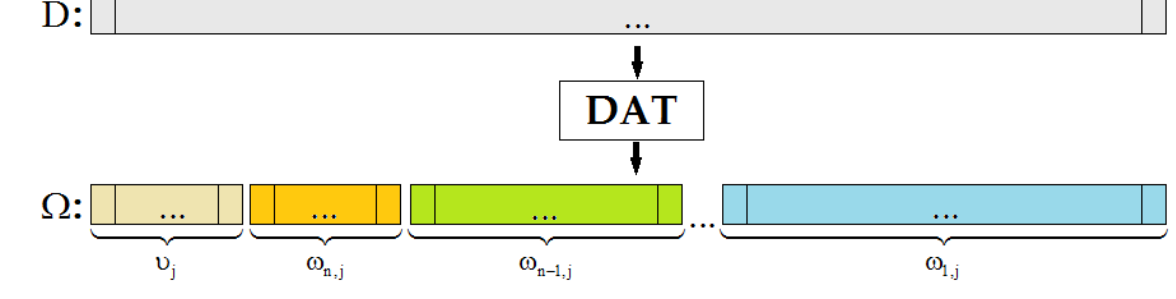
Figure 2. Discrete atomic transform of an array.